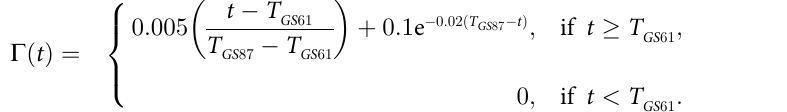
Table 2. Model accounting for diversity within the pathogen population (fungicide only). The population model, which accounts for diversity within the pathogen population (Table